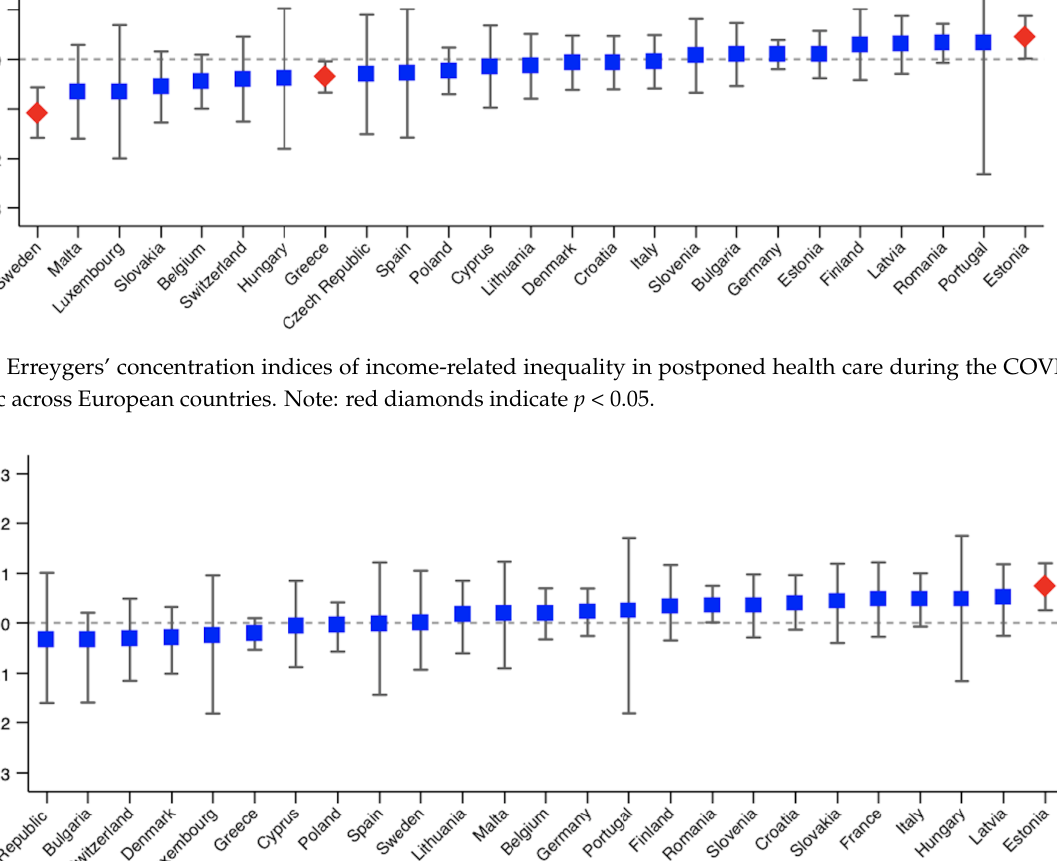
Figure 3. Erreygers´ concentration indices of income-related inequality in denied health care during the COVID-19 pan- demic across European countries. Note: red diamonds indicate p < 0.05. Figure 4. Horizontal inequity indices in denied health care during the COVID-19 pandemic across European countries. Note: red diamonds indicate p < 0.05. Bootstrapped bias corrected 95% confidence intervals.